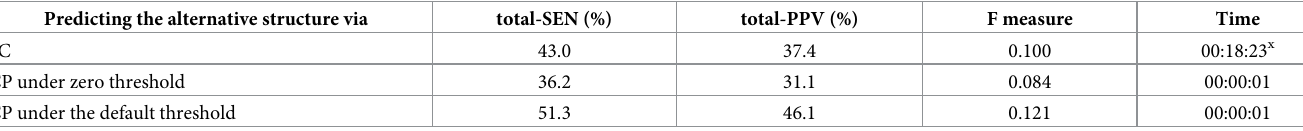
Table 1. Alternative-structure prediction performance in the Barsacchi Structural